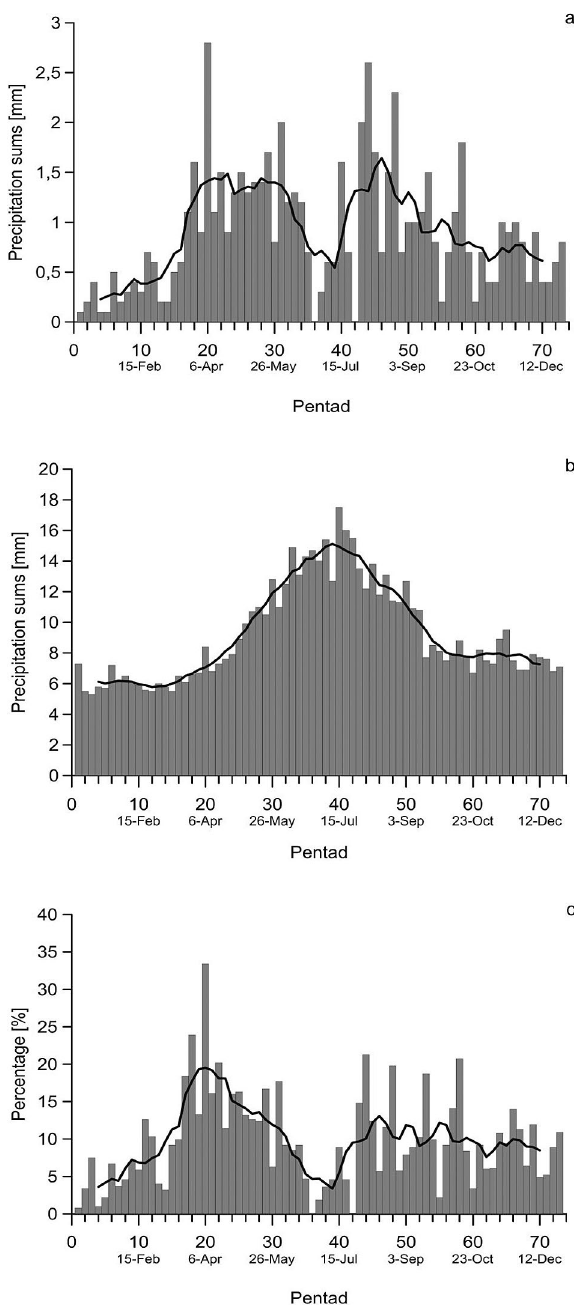
Fig. 8. Mean pentad of MCP daily totals [mm] (a), total pre- cipitation in Poland [mm] (b) and proportion of MCP in total precipitation [%]